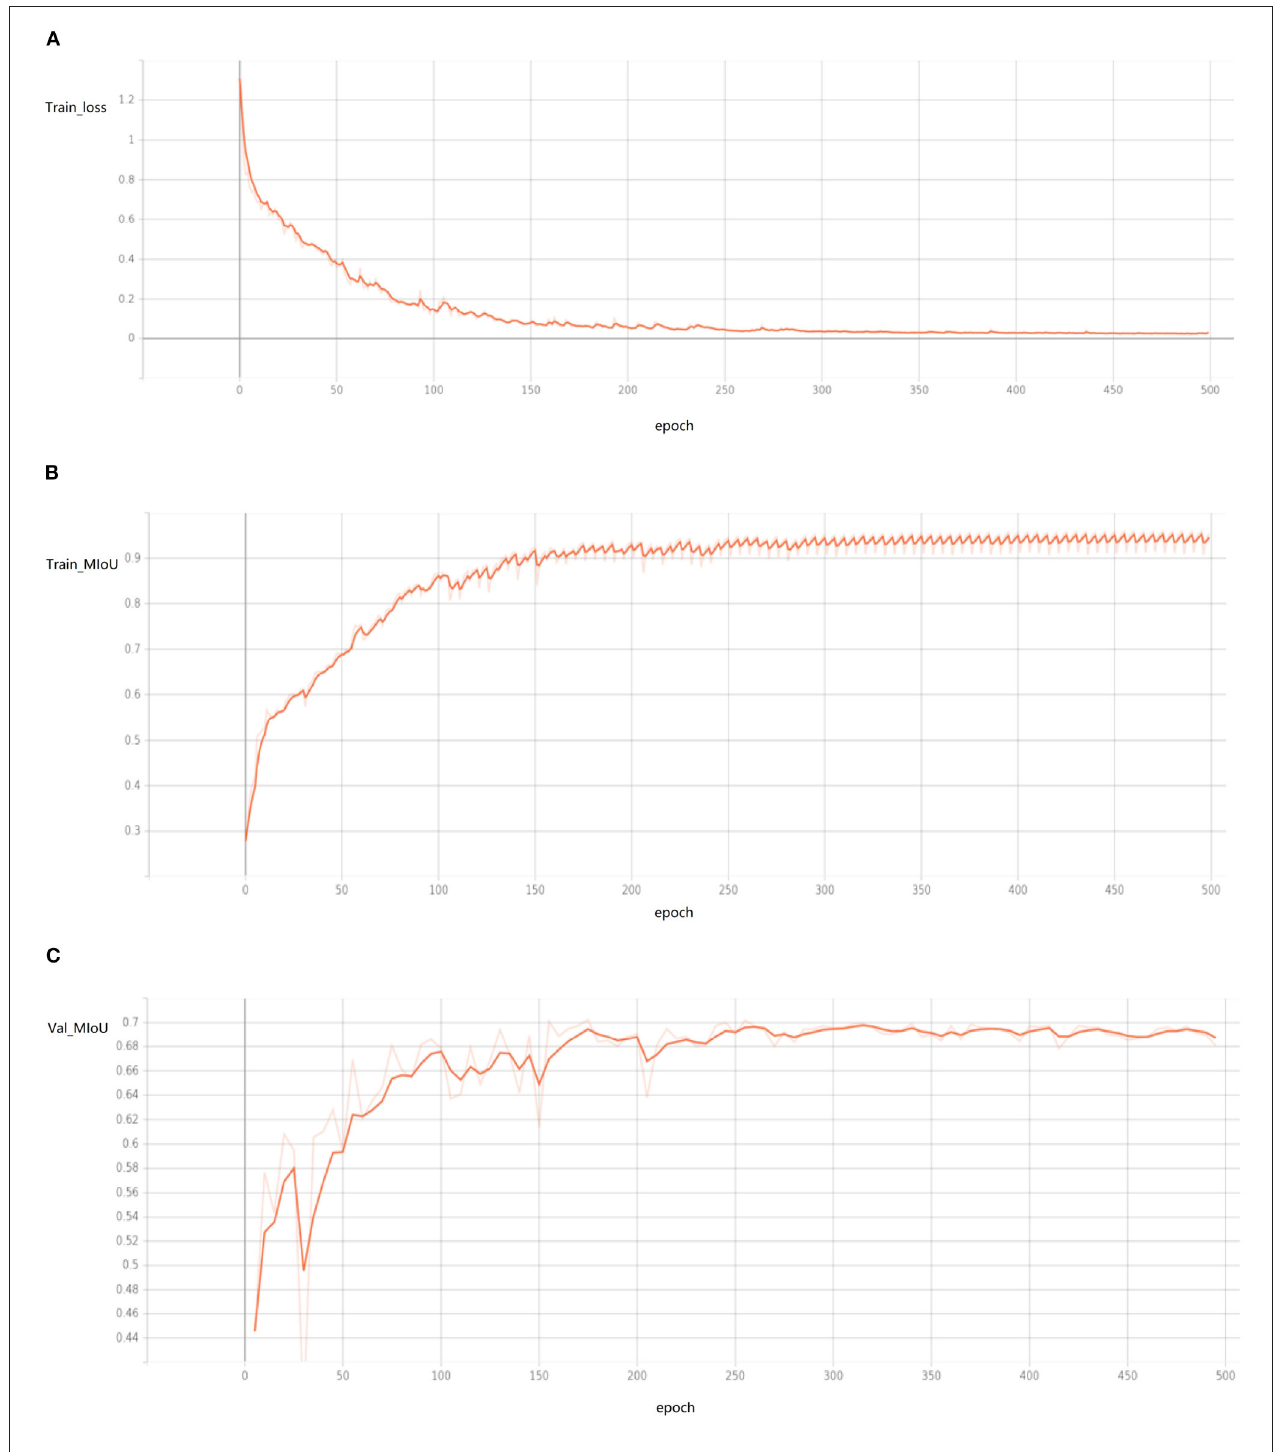
FIGURE 10 | The curve of training process (drawn by Tansorboard) shows the training process of 500 epochs, but in fact the network has basically converged when there are < 200 epochs. (A) Train loss, (B) train MIoU, (C) val MIoU.